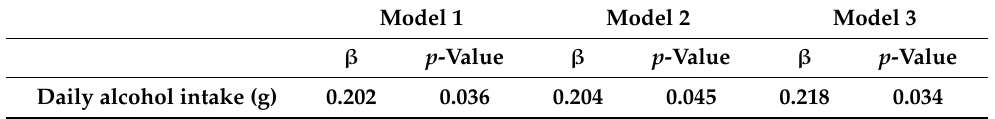
Table 5. Association between daily alcohol intake and IgE